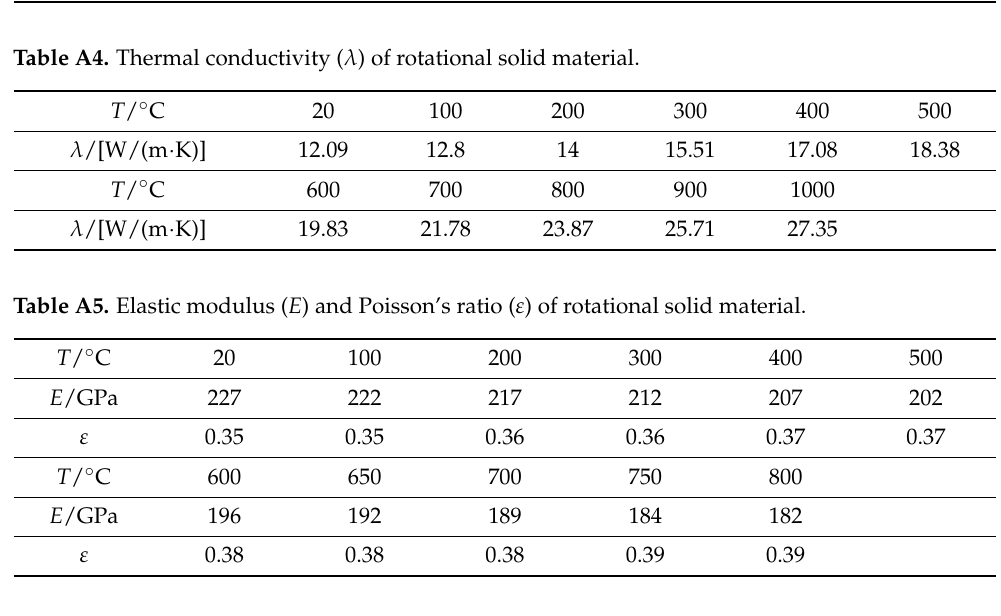
Table A6. Thermal expansion coefficient ( α ) of rotational solid